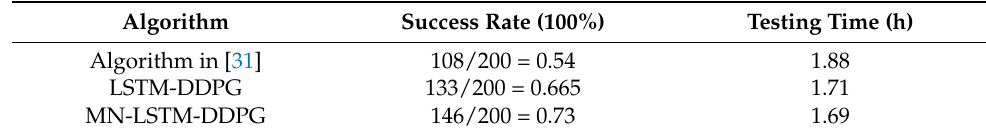
Table 3. Comparison of test results of the improved algorithm in simulation Figure